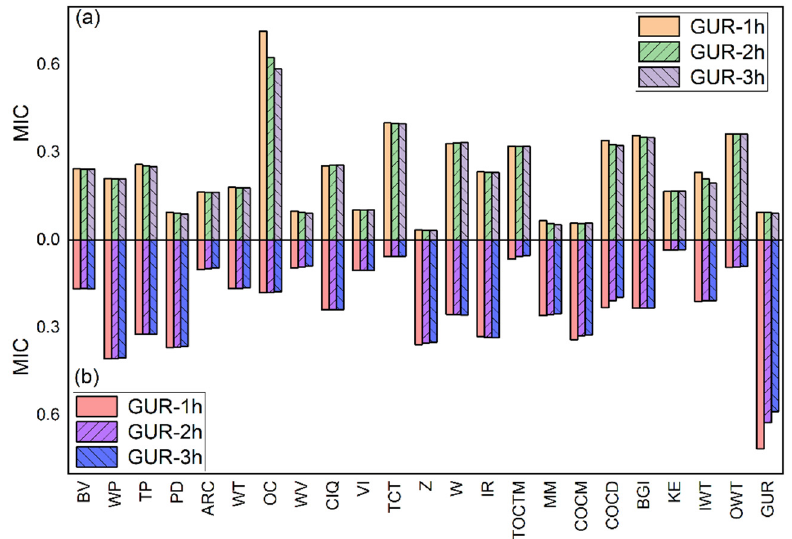
Figure 5. The values of MIC between the selected input parameters and the output parameters for BDS ( a ) and NDS ( b ). BDS ( a ) and NDS ( b ).